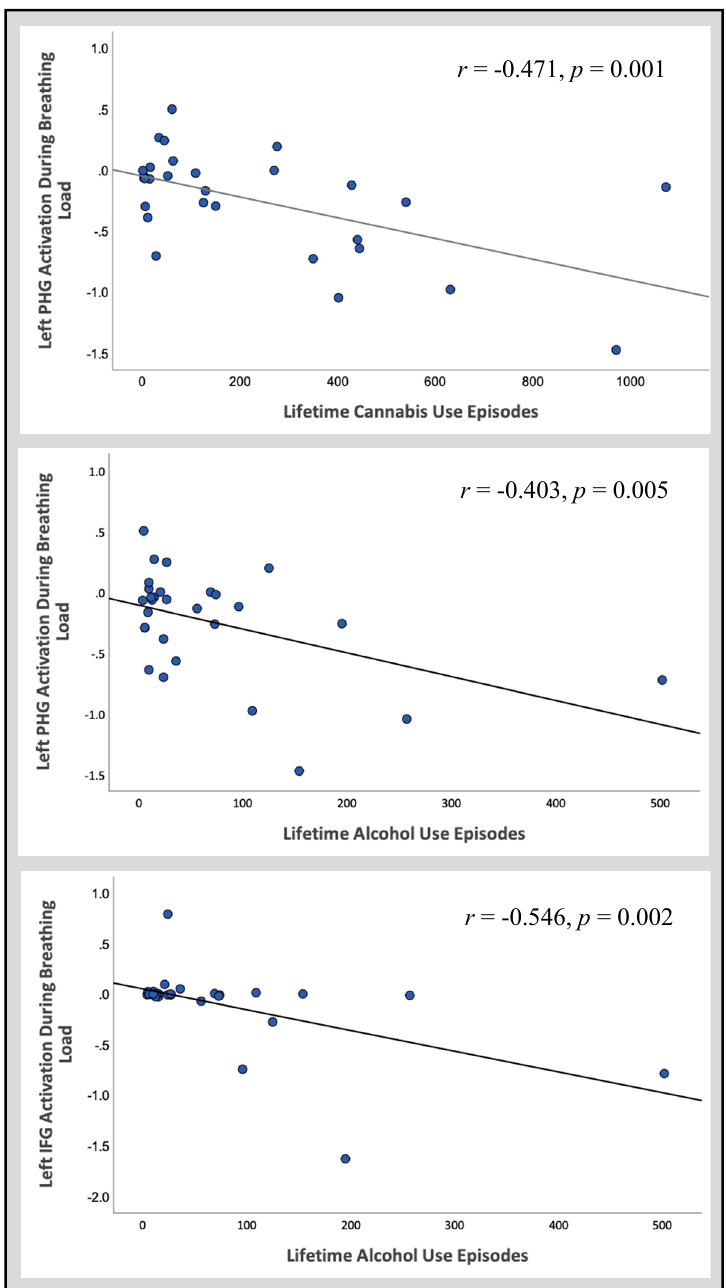
Figure 3. Follow-up correlations between activation in significant regions of interest and reported lifetime episodes of cannabis and alcohol use across all substance users.